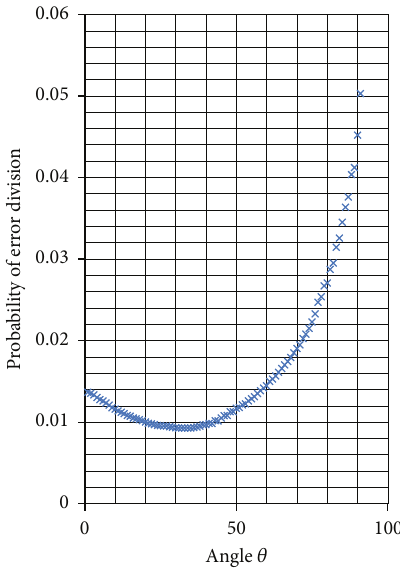
Figure 4: Relationship between 𝑃 err (𝜃) and angle 𝜃